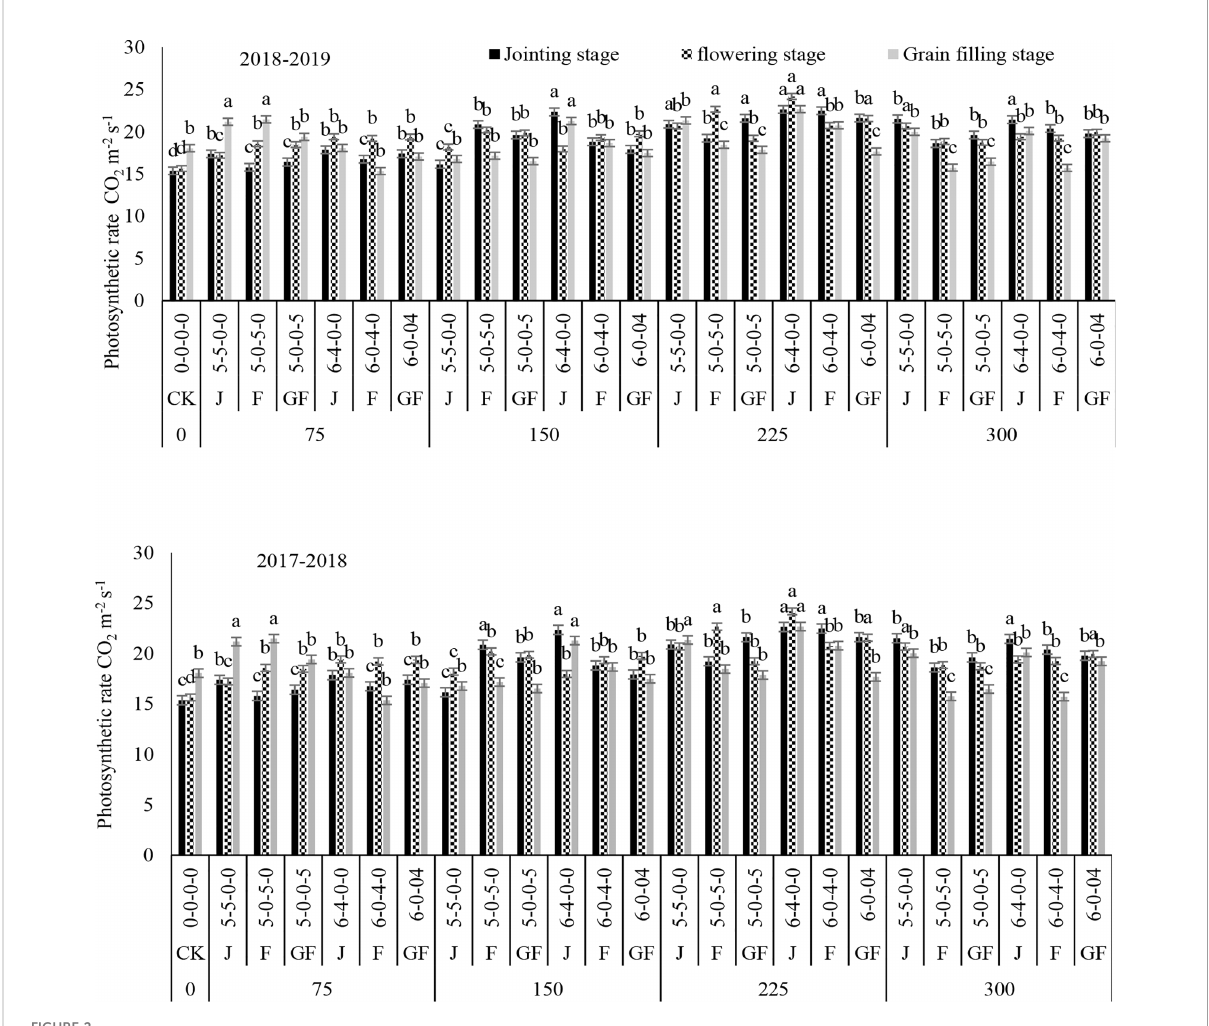
FIGURE 2 Effect of nitrogen fertilizer management on the photosynthetic rate of winter wheat. JS , jointing stage; FS , fl owering stage; GF , grain fi lling stage. Different letters in above bars indicate a signi fi cant difference